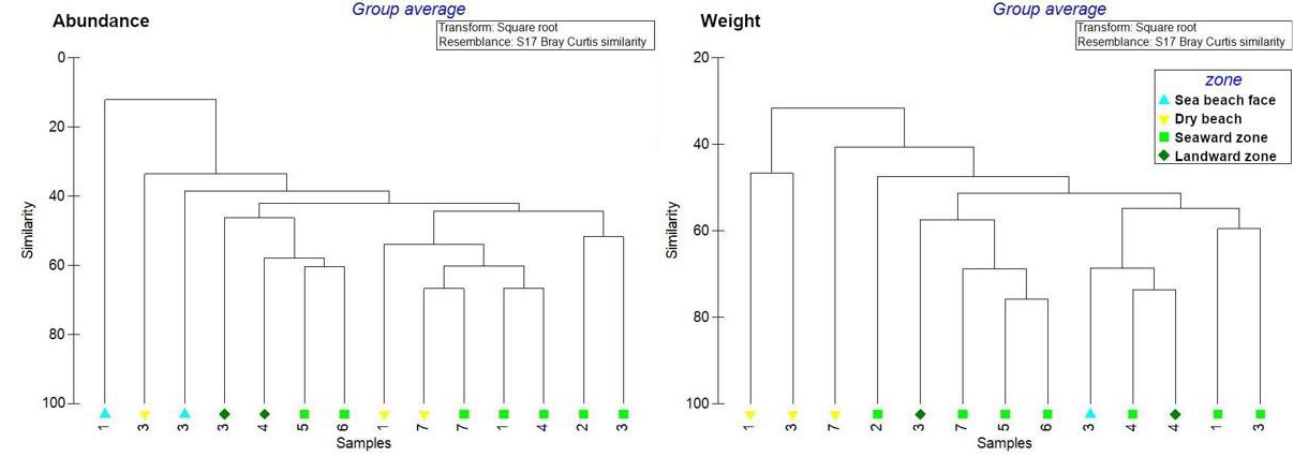
Figure 6. Cluster analysis for abundance and weight of litter items at the Caribbean Sea sites.